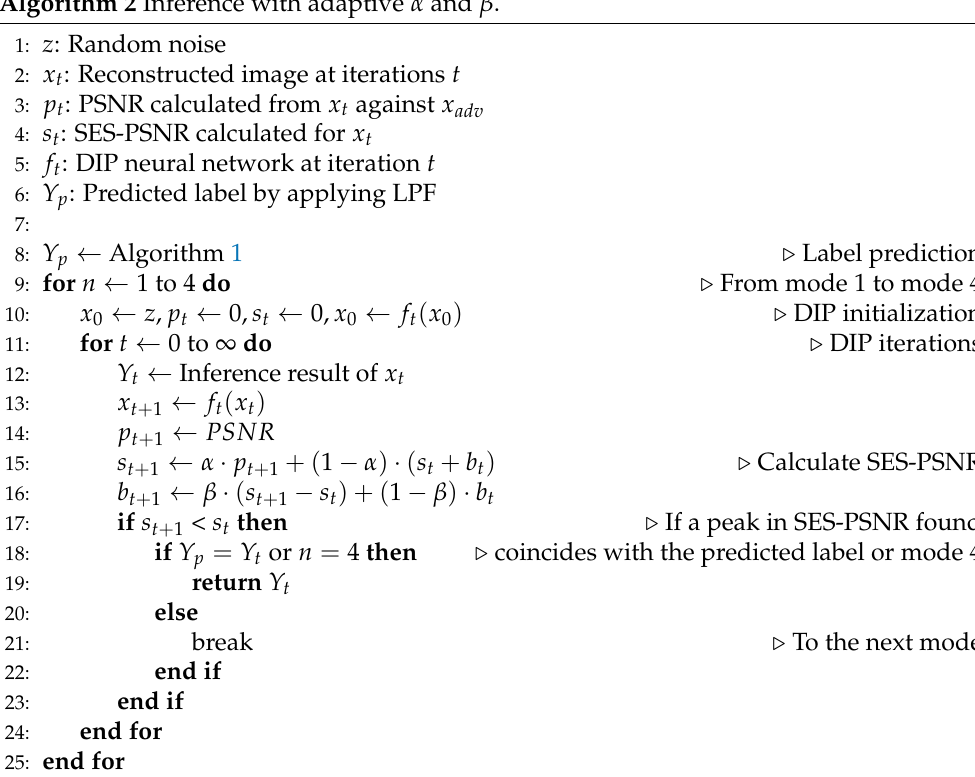
Algorithm 2 Inference with adaptive α and β .